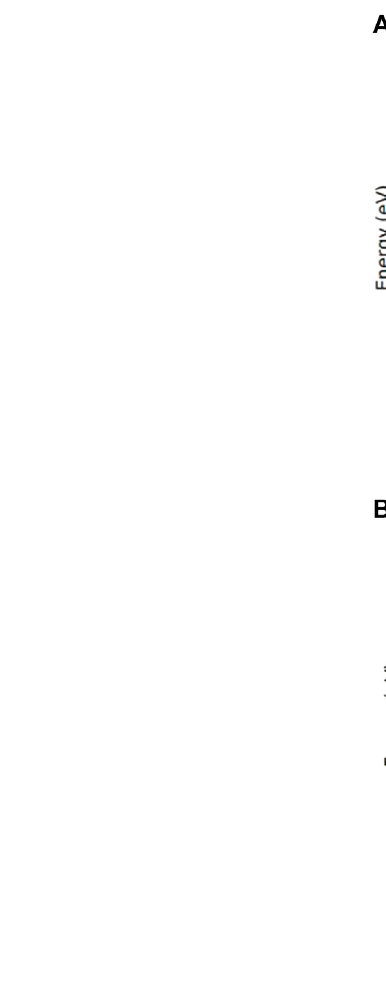
FIGURE11| Band structuresof (A) InAsand (B) GaSbobtainedbythehybridQSGW (black)and ETBMcalculations(the bluecolordenotes thesp3s p model, and the red color represents the sp3d5s p model). Whereas the lowest conduction band is fi tted moderately well by the sp3s p model along with the left two segments (L → Γ → X), it is almost fl at between the X, W, and U, K points, re fl ecting the poorly described transverse mass. The sp3d5s p method resolves this